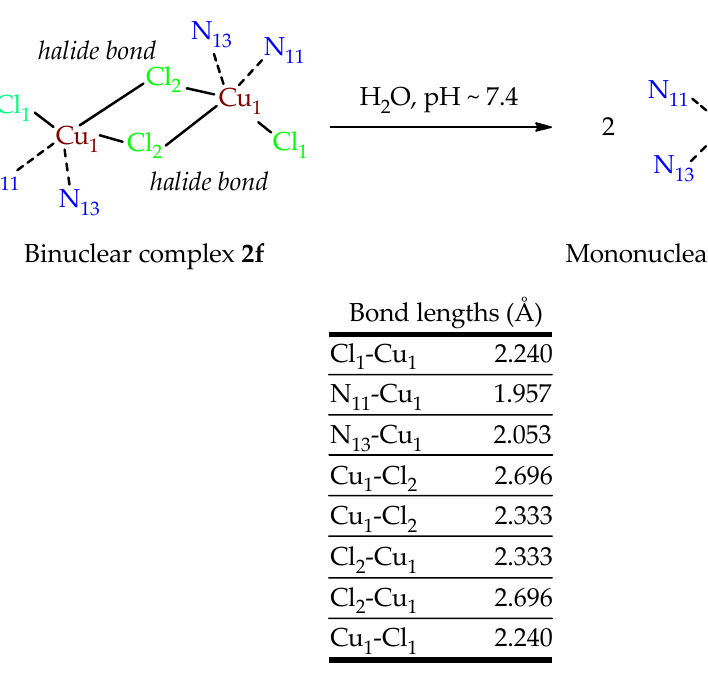
Figure 9. Selected bond lengths in the complex 2f.